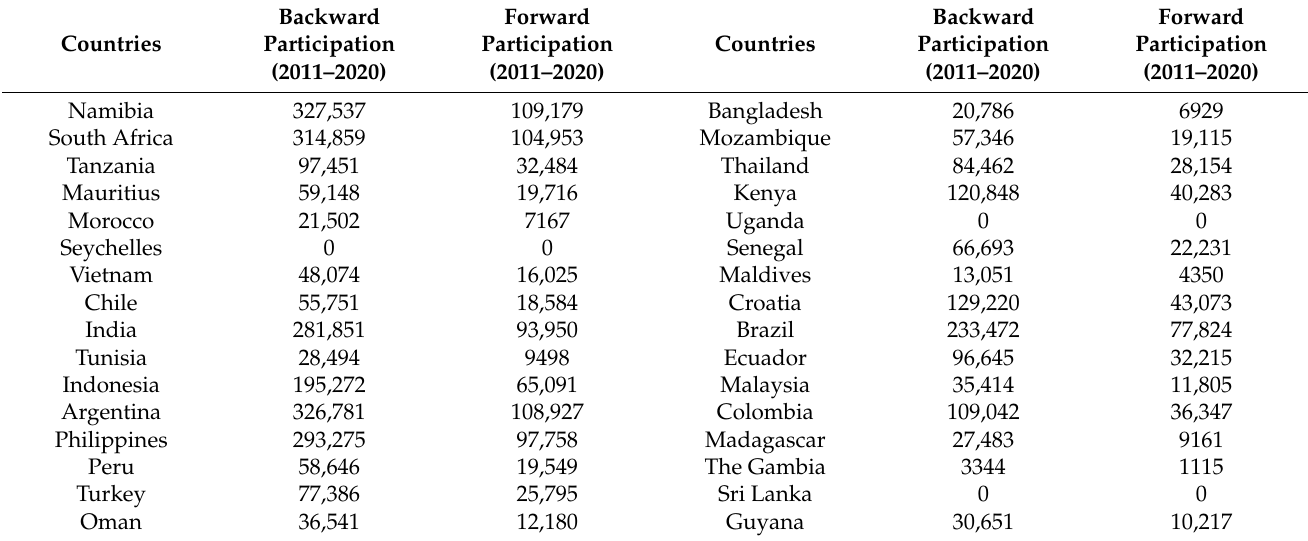
Table A3. Value-added decomposition of